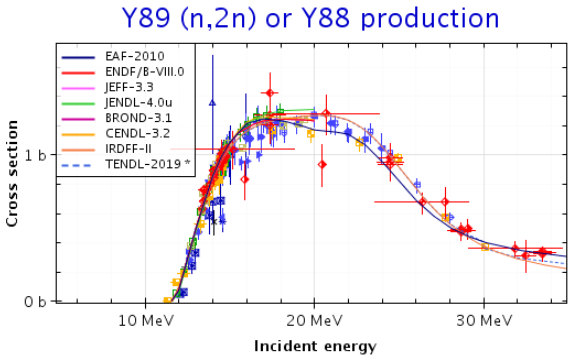
Figure 6. Experimental and evaluated cross-section data for 89 Y(n,2n) 88 Y reaction plotted by JANIS [19].